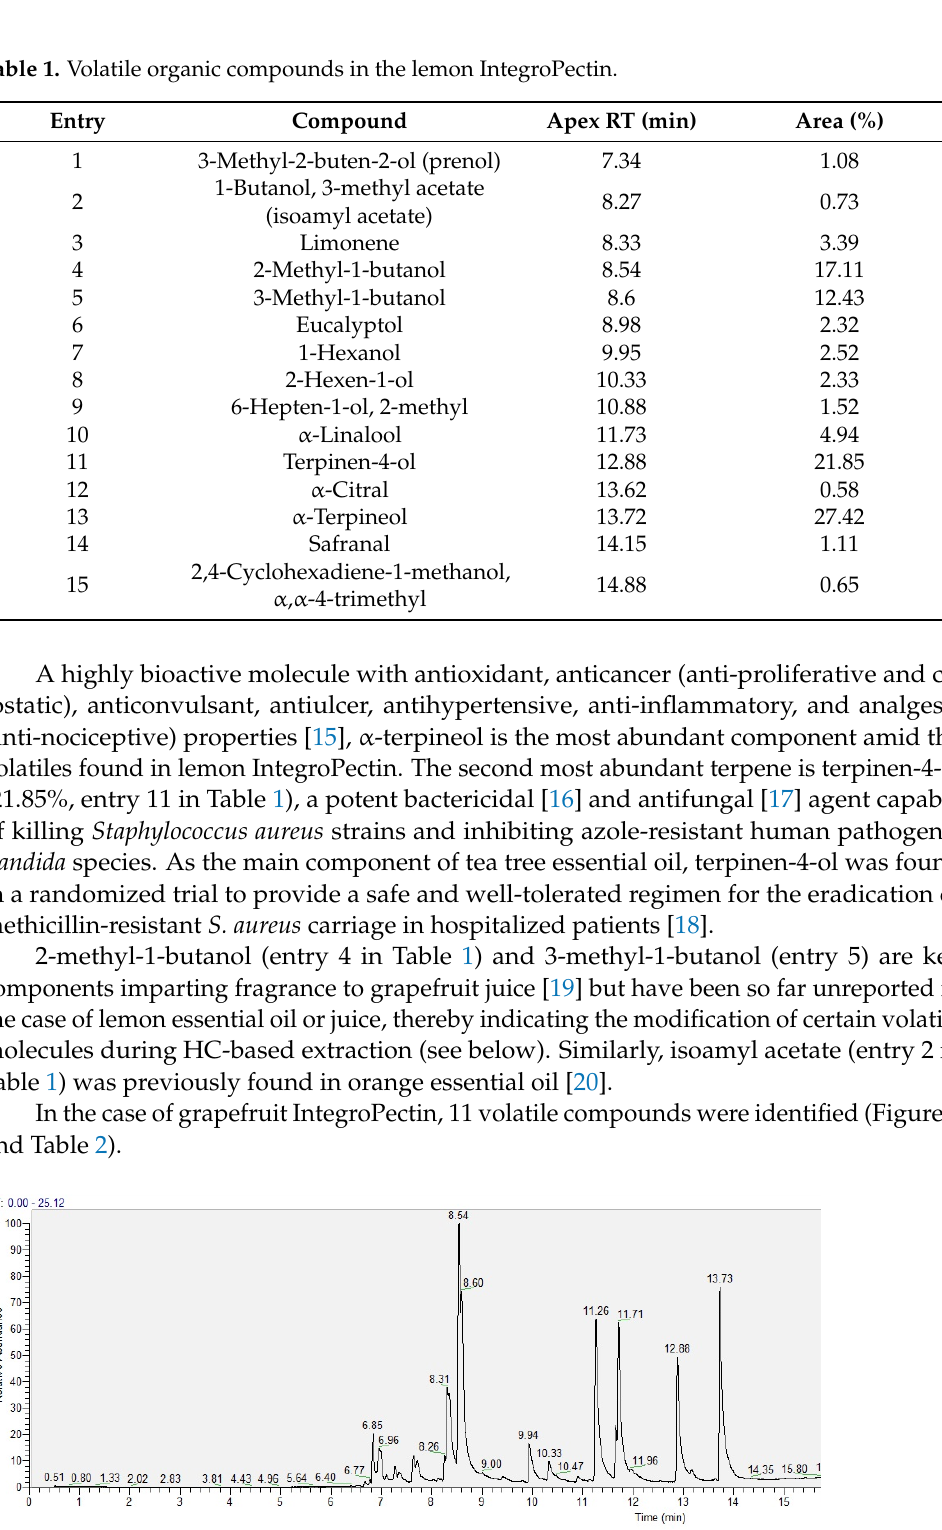
Table 1. Volatile organic compounds in the lemon IntegroPectin.